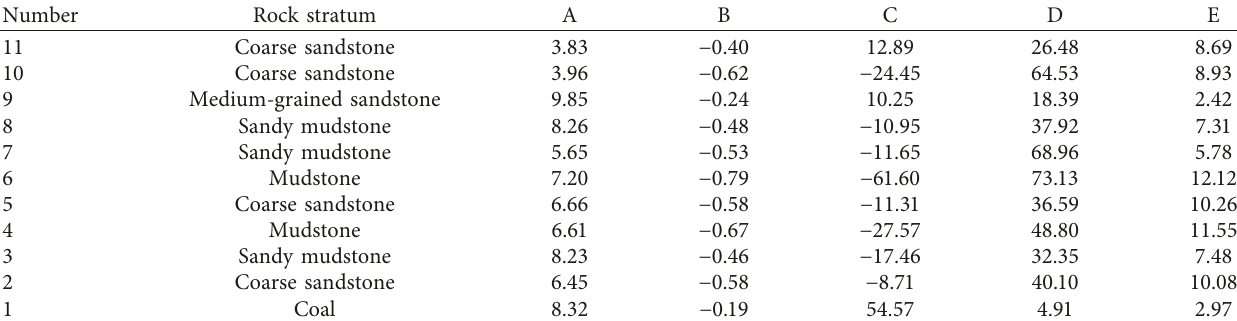
Table 5: Similar material ratio of each rock